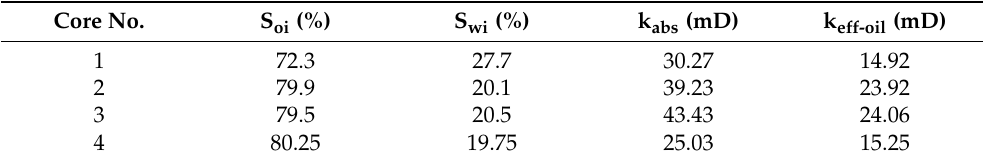
Table 2. Permeability and saturation